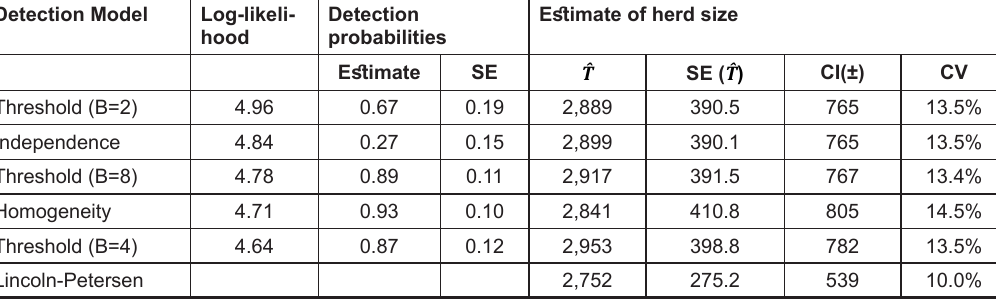
Table 40: Rivest Estimator results for the Tuktoyaktuk Peninsula Herd in 2009. The Lincoln-Petersen estimate is based on Davison et al . (2014).